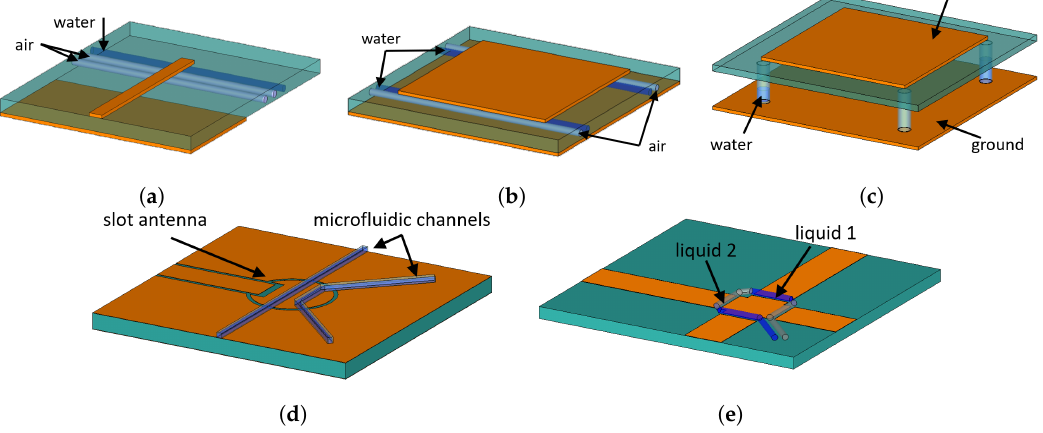
Figure 5. Planar antennas with microfluidic channels. ( a ) [81], ( b ) [82,83], ( c ) [84], ( d ) [85], ( e )